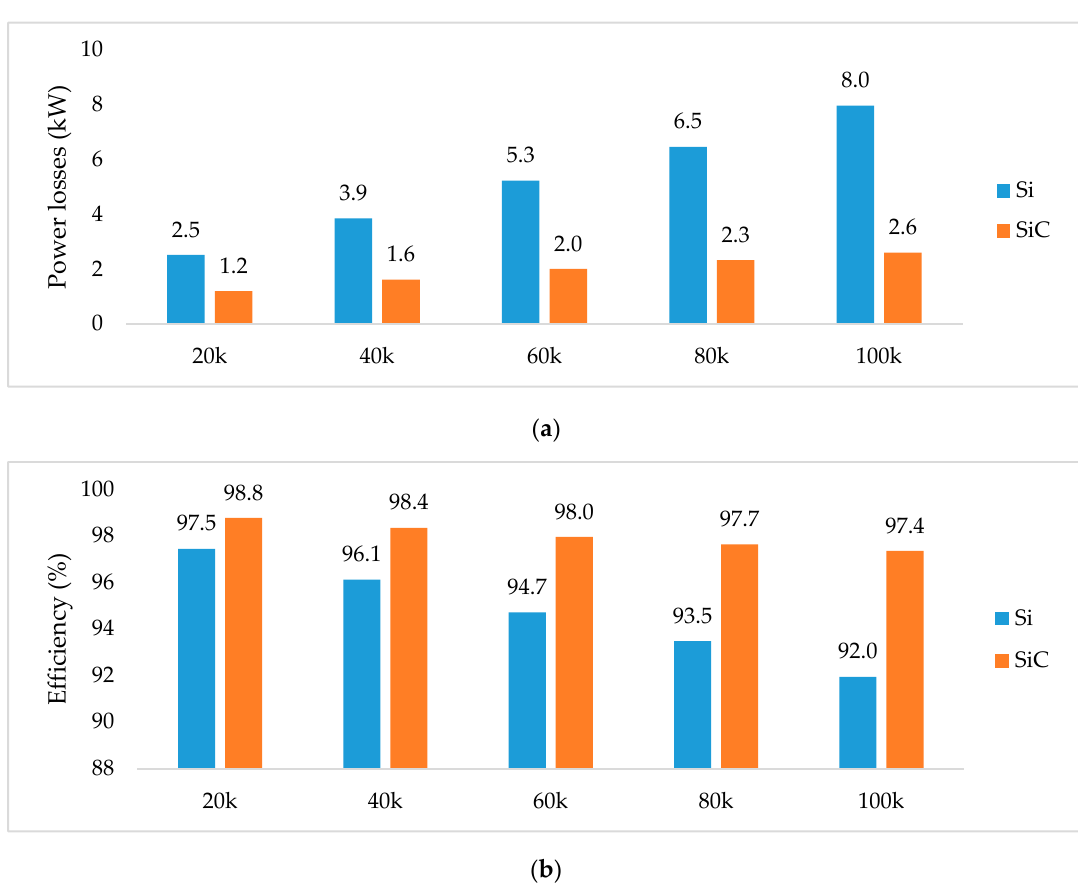
Figure 19. Comparative performance of using Si and SiC semiconductors at different switching frequencies and load (100 kW) and input voltage per MMC HBSM (300 V): ( a ) Semiconductor power losses; ( b ) MMC efficiency.